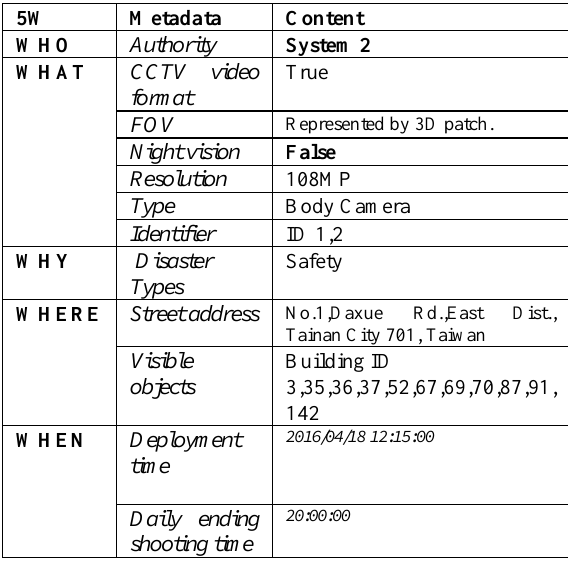
Table 3. System 2’s CCTV Metadata